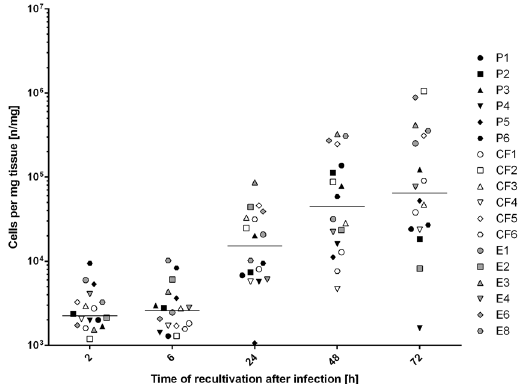
Figure 6. Kinetics of fungal proliferation in G. mellonella during infection. E. dermatitidis cells were recovered from infected G. mellonella caterpillars 2 h, 6 h, 24 h, 48 h, and 72 h after infection by CFU experiment (n = 18 strains, 6 from each group). Growth curve shows a sigmoidal development, all tested strains showed a similar growth rate over a period of 72 h. n = 2 G. mellonella caterpillars per test were used, every test was repeated 3